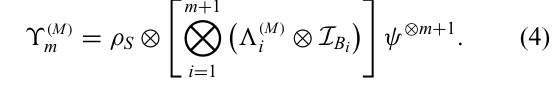
FIG. 1. A non-Markovian noisy RB sequence as a process- tensor contraction . An initial system-environment ( SE ) state ρ is acted on with a random Clifford element G 1 on S alone, induc- ing a noise map (cid:3) 1 on SE , followed by a random Clifford G 2 inducing noise (cid:3) 2 , and so on until the undo map G m + 1 is applied with some noise (cid:3) m + 1 . Finally, a POVM element M is applied on S and the environment is traced out (grounding symbol). This can be described by the contraction of a tensor ϒ m (upper box) comprising the initial state together with the noise process, with a tensor C m describing the sequence of applied Clifford gates, all followed by applying M